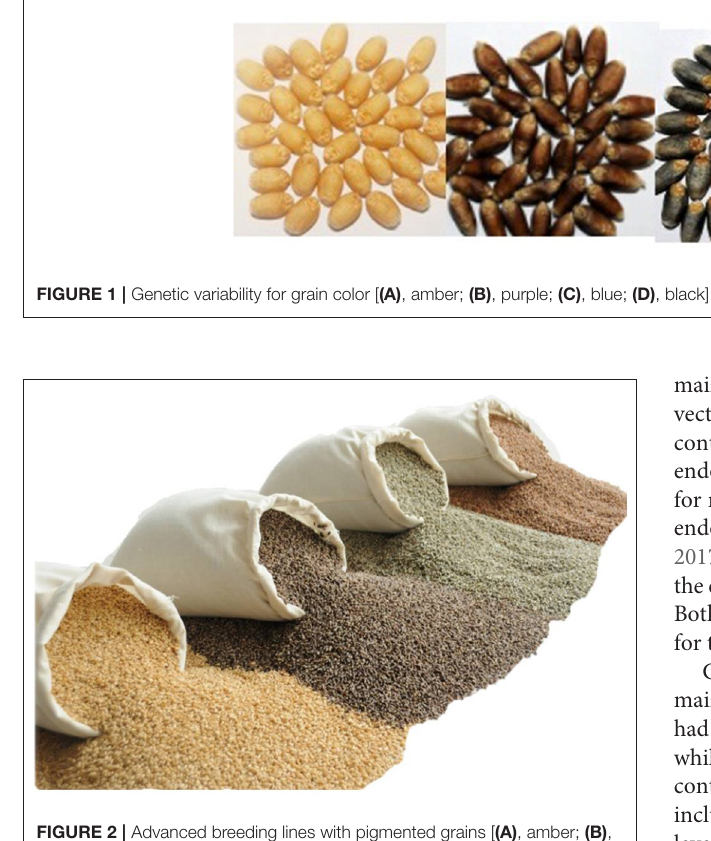
FIGURE 2 | Advanced breeding lines with pigmented grains [ (A) , amber; (B) , black; (C) , blue; (D) , purple] developed by crossbreeding and selection in